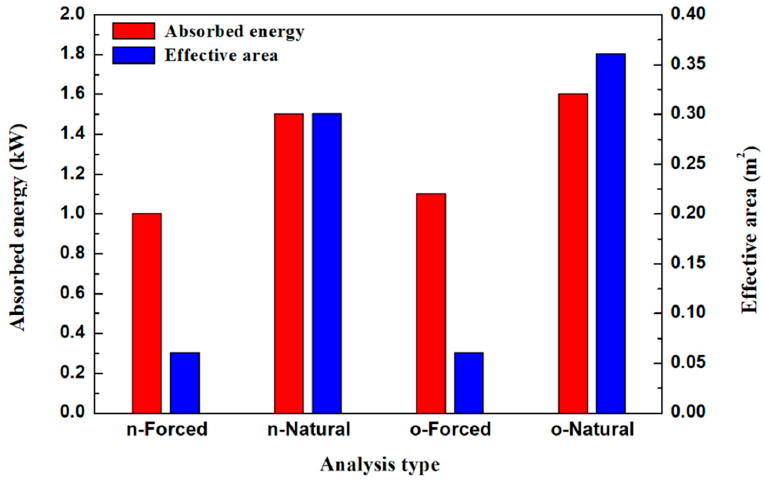
Figure 8. Heat absorption with different heat exchanger shapes and air flow.